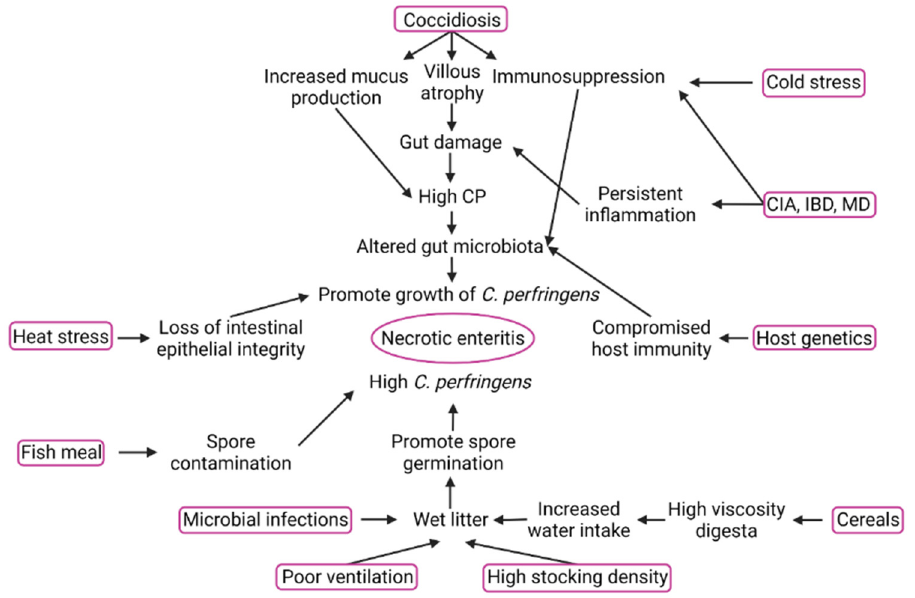
Figure 3. Predisposing factors of NE and their mechanism of action. Created with Biorender.com (accessed on 30 May 2022) .